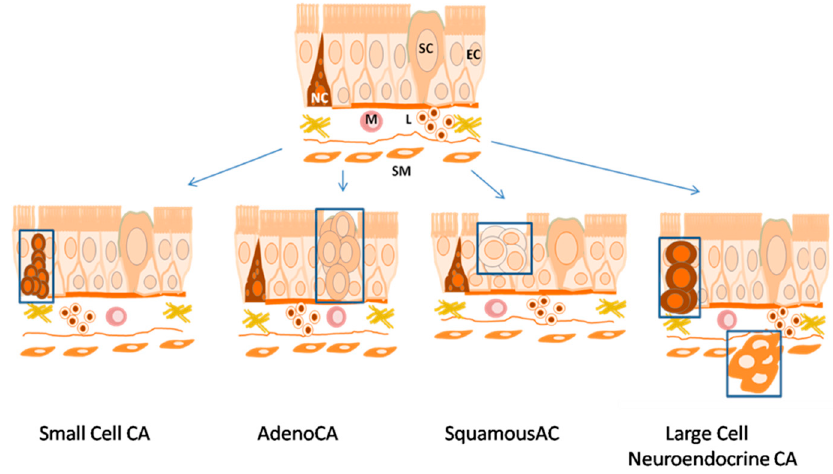
Figure 2. Histogenesis of histological types of lung cancer. SM—Smooth Muscle; M—Macrophage; L—Lymphocyte; NC—Neuroendocrine Cell; EC—Epithelial Cell; SC—Secretory Cell.